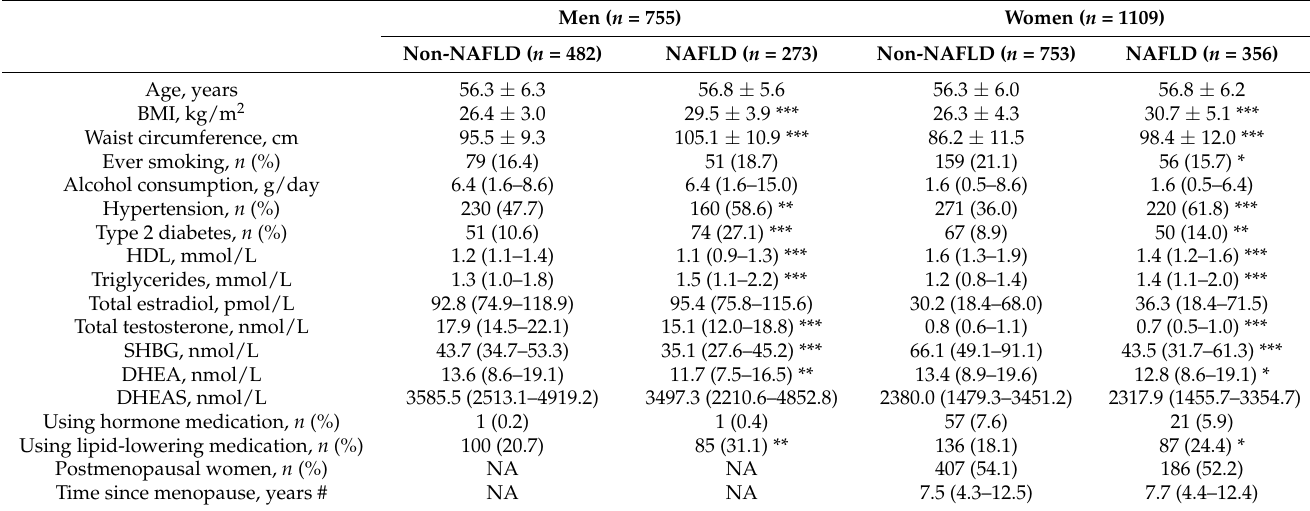
Table 1. Characteristics of the study population in the Rotterdam